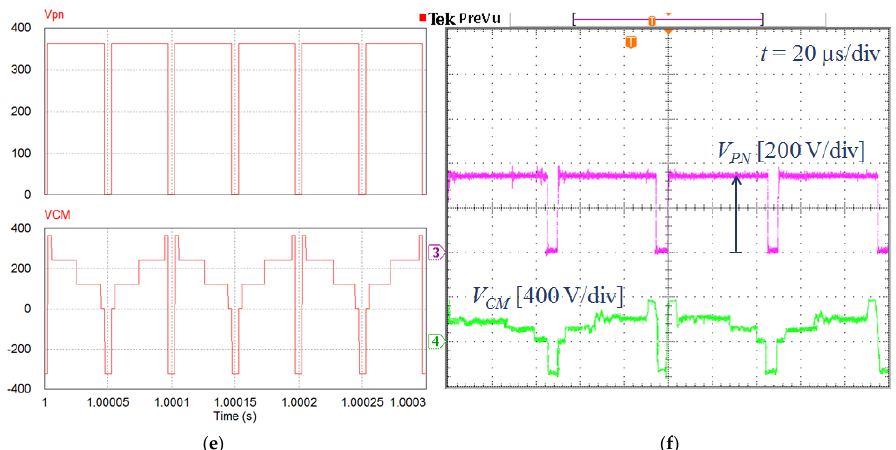
Figure 9. AqZSI under the conventional SVM method. ( a , c , e ) Simulation results and ( b , d , f ) experimental results. From top to bottom: input voltage, output currents, capacitor C 1 voltage, v ab voltage, DC-link voltage, and CMV.